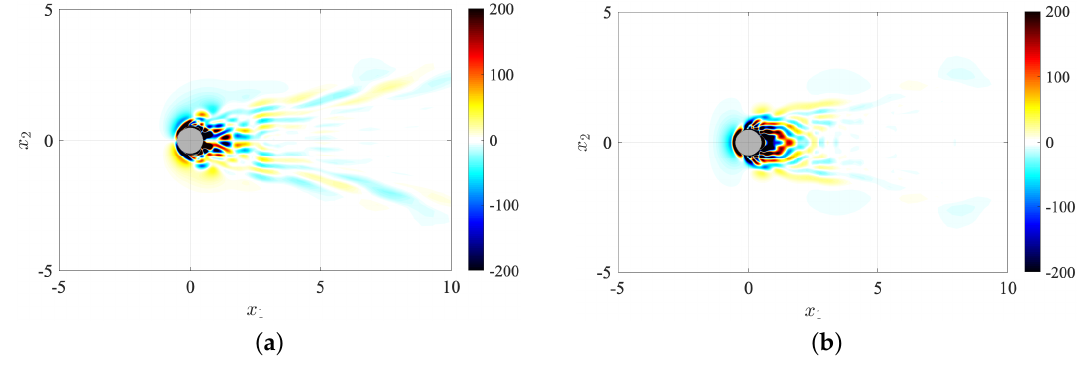
Figure 9. Gain of the control law (SF-1) for ( a ) u 1 and ( b ) u 2